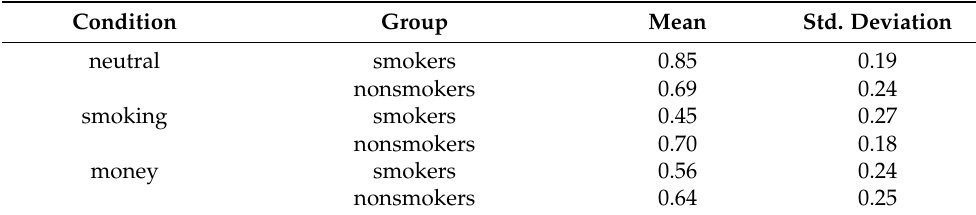
Table 1. Proportion of inhibitions to no-go trials for smokers and nonsmokers in the neutral, smoking, and money conditions. Table 3. Proportion of omissions in go trials for smokers and nonsmokers in the neutral, smoking, and money conditions.